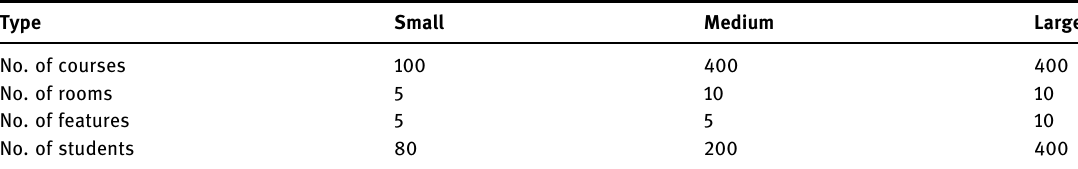
Table 1: The parameter values for the di ff erent types of course scheduling problems